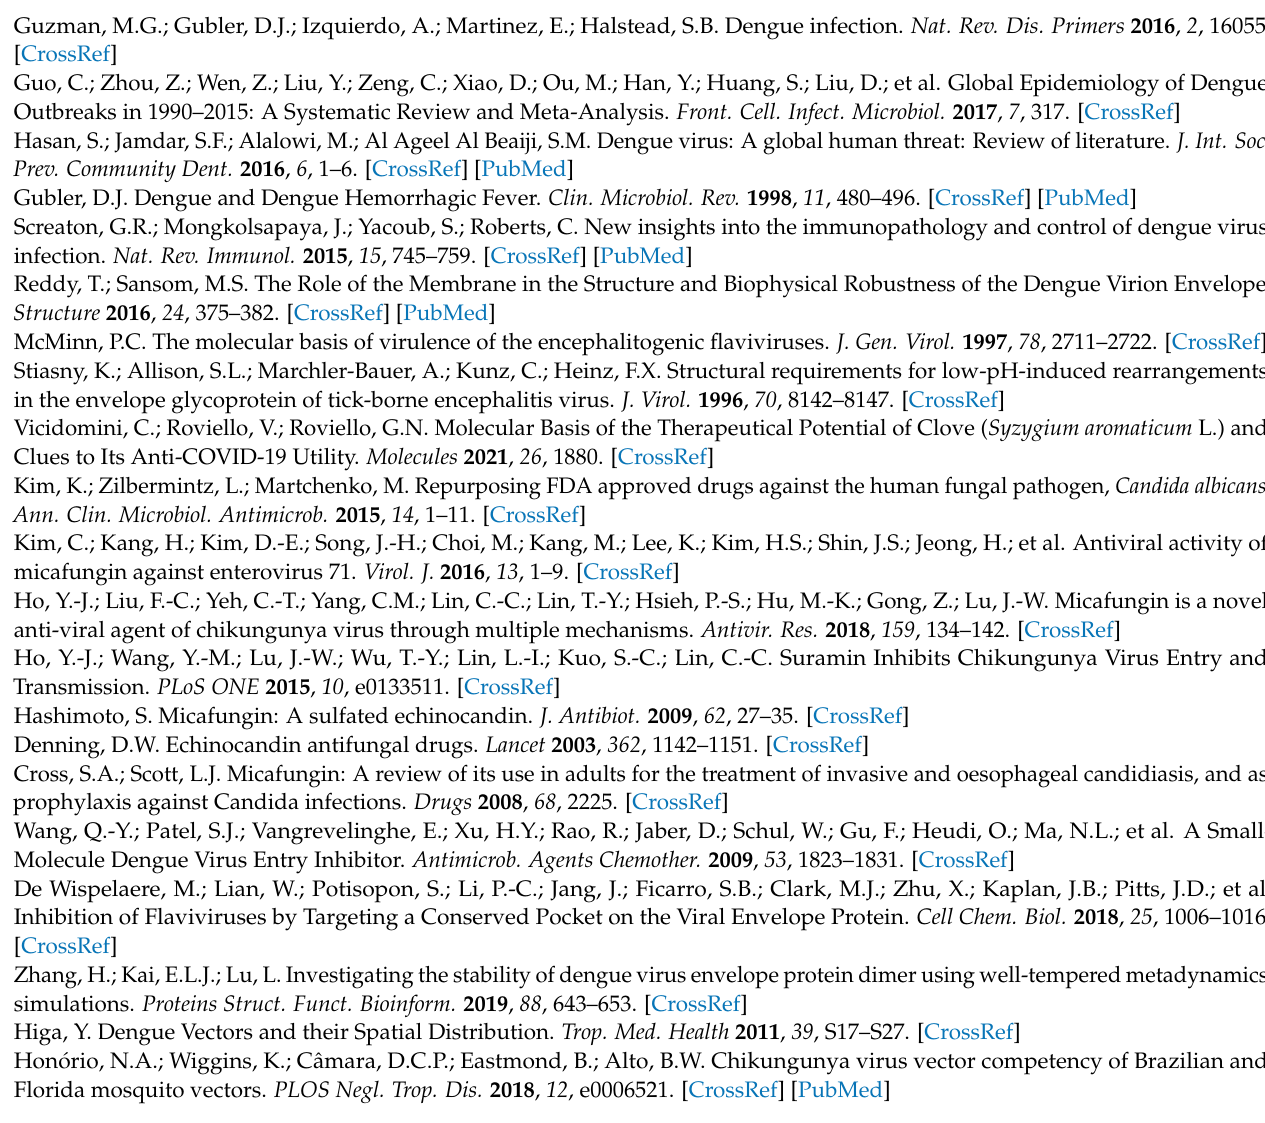
Table S1: RT-qPCR primers, Table S2: The structure, preparation, Cytotoxicity (CC 50 ), inhibition concentration (IC 50 ), and selective index (SI) of micafungin and its